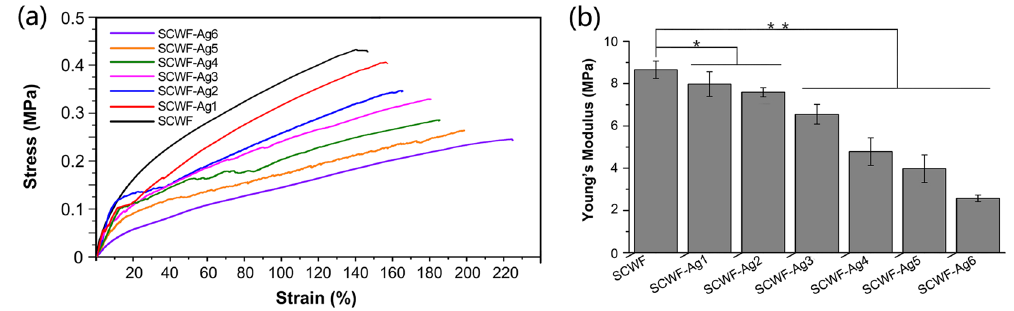
Figure 3. Mechanical properties of SCWF and SCWF-AgNPs. ( a ) Representative strain-stress curves. ( b ) Young’s modulus ( * P < 0.05, ** P < 0.01, n =